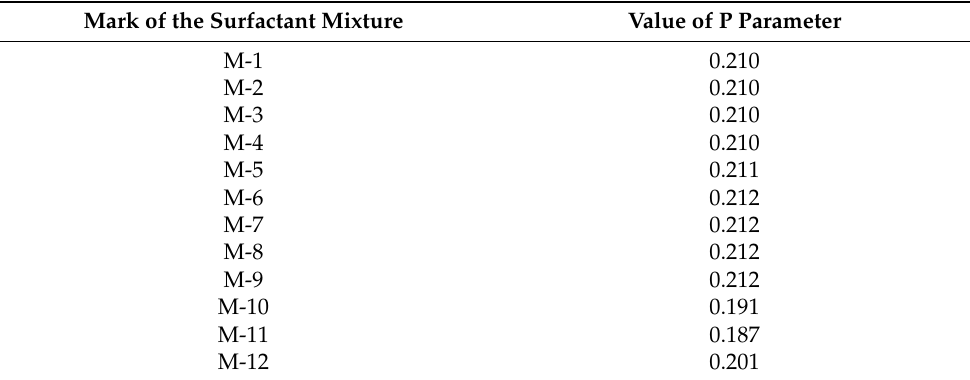
Table 4. Value of P parameter of each surfactant mixture. Mark of the Surfactant